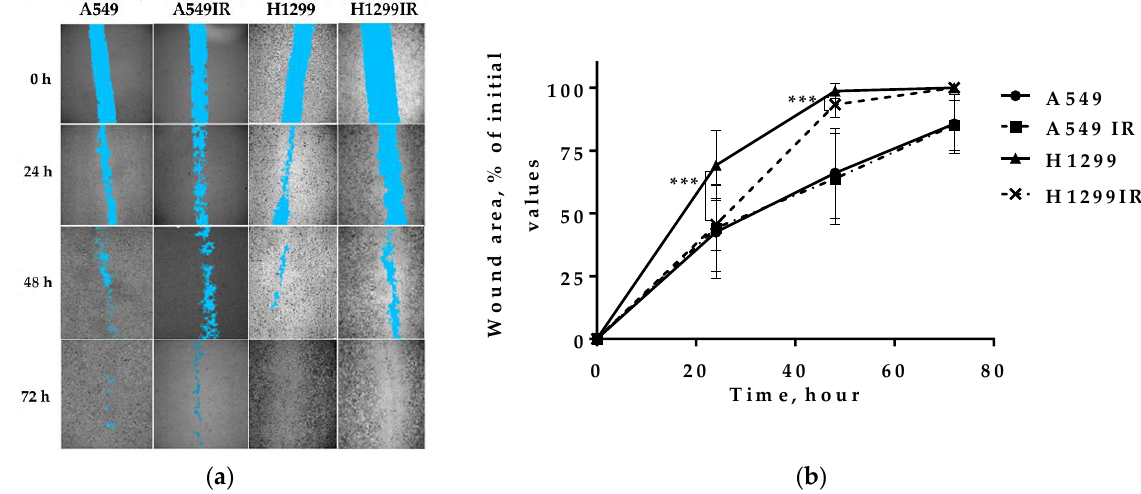
Figure 4. The wound healing assay was used to detect the migration ability of parental and MFR-surviving A549 and H1299 cells. ( a ) After mechanical wounding cells were grown for 24 h, 48 h and 72 h. Cell free area shown in blue. ( b ) Percentage of cell free area in each condition was calculated. *** p < 0.001.